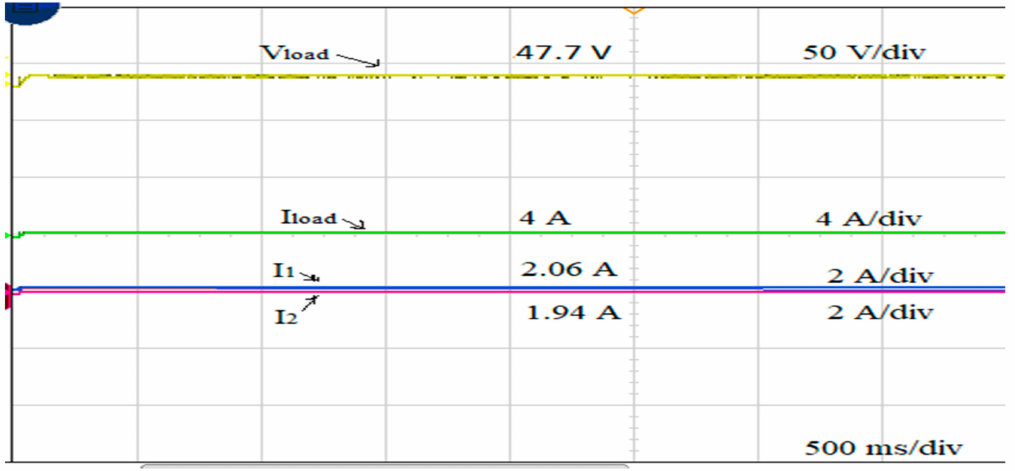
Figure 19. Experimental results for different cable resistances for proposed droop control.